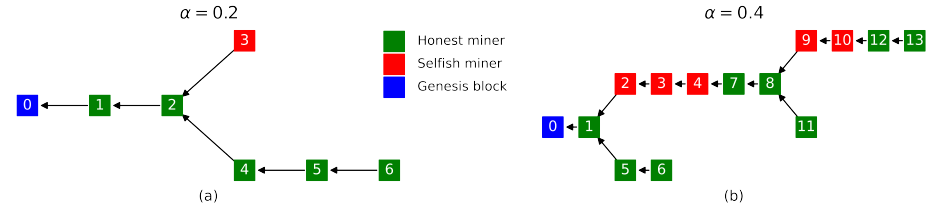
Figure 1. Visualisation of block trees for different selfish shares of the network’s hashing power ( α ). ( a ) in which selfish miner controls 20% share of the hashing power; ( b ) in which selfish miner controls 40% share of the hashing